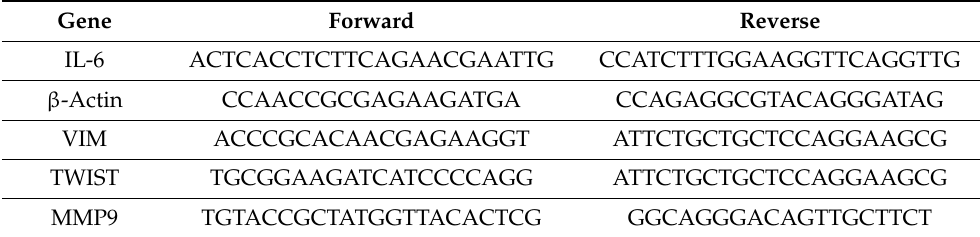
Table 1. qPCR primers used in this study and their